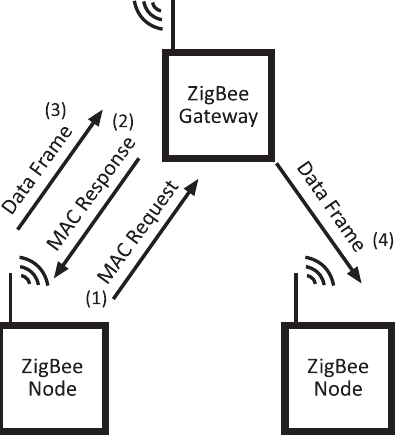
Figure 7. A diagram of an example of data exchange between same-network ZigBee